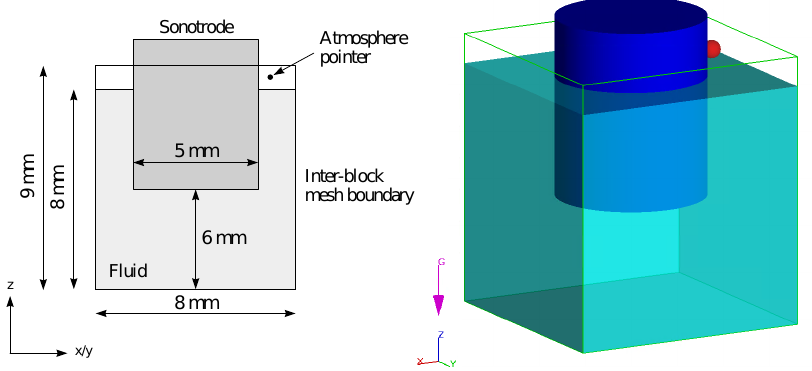
Figure 1. Geometric alignment of the simulation model